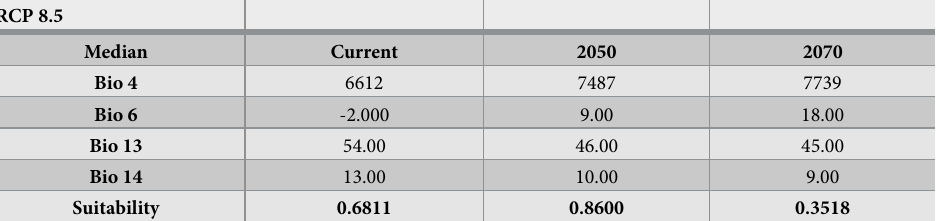
Table 5. Evolution of the medians for the selected bioclimatic variables under the RCP 8.5 scenario. The evolution of median suitability is shown on the bottom row. All the values are taken at the current locations of G . bermejoi